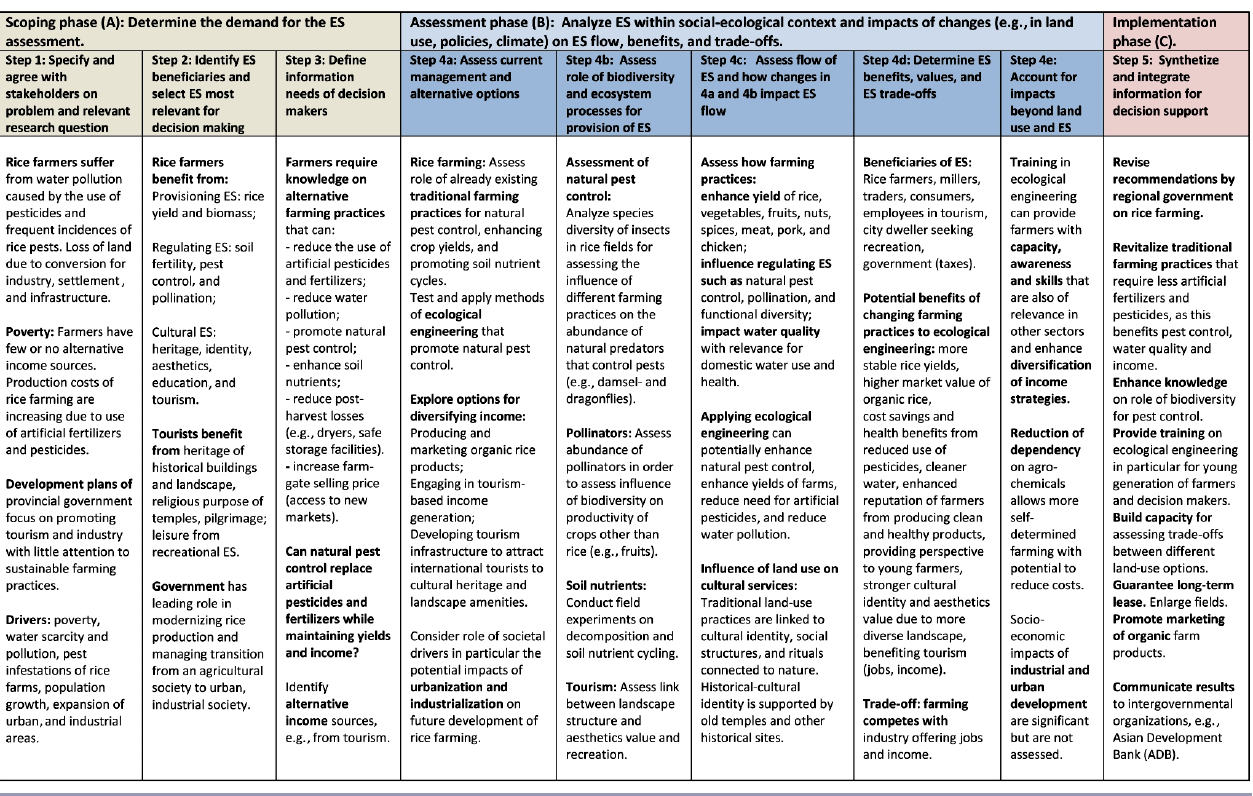
Fig. 4 . Problem-oriented approach for assessing ecosystem services (ES): the case of the LEGATO project on rice farming in Vietnam (Settele et al.